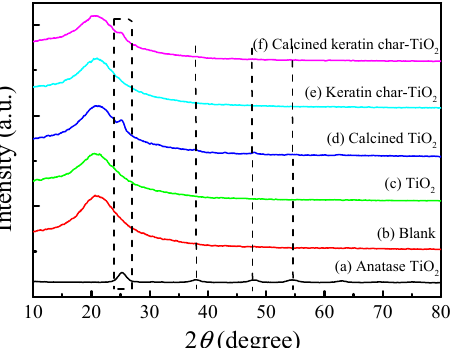
Figure 3. XRD patterns of (a) TiO 2 particles, (b) blank quartz glass, TiO 2 films (c) before and (d) after calcination, keratin char-TiO 2 composite films (e) before and (f) after calcination. calcination, keratin char-TiO 2 composite films ( e ) before and ( f ) after